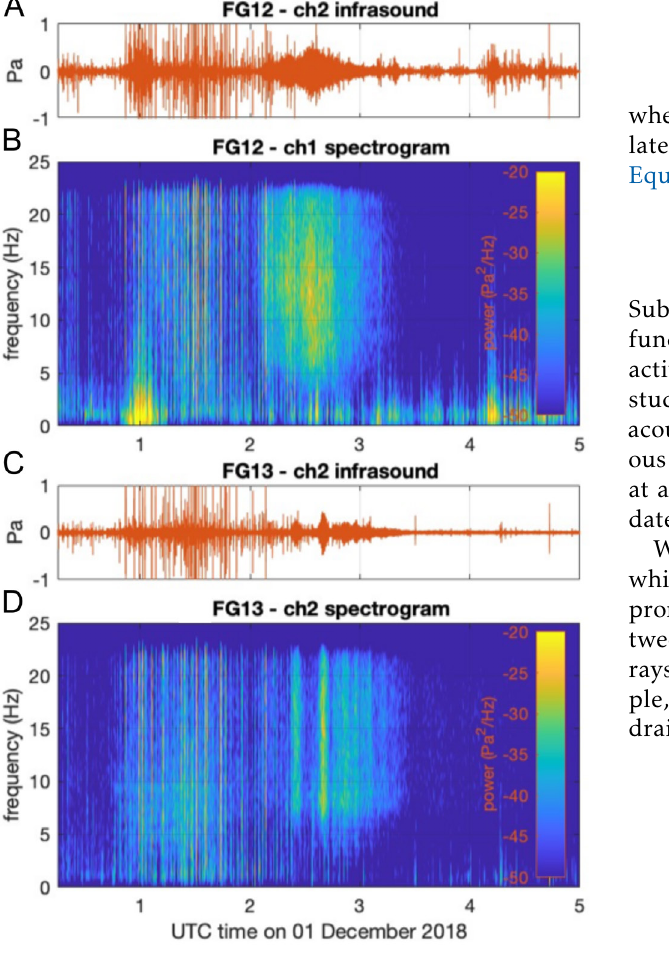
Figure 3: Spectrogram of channel 2 waveforms for both FG12 and FG13 over the entire 5-hour recorded event, in- cluding the lahar (~2:06:00 UTC to 3:05:00 UTC). The spectrogram was calculated for 10 s windows with 5 s overlaps and for infrasound data filtered above 1